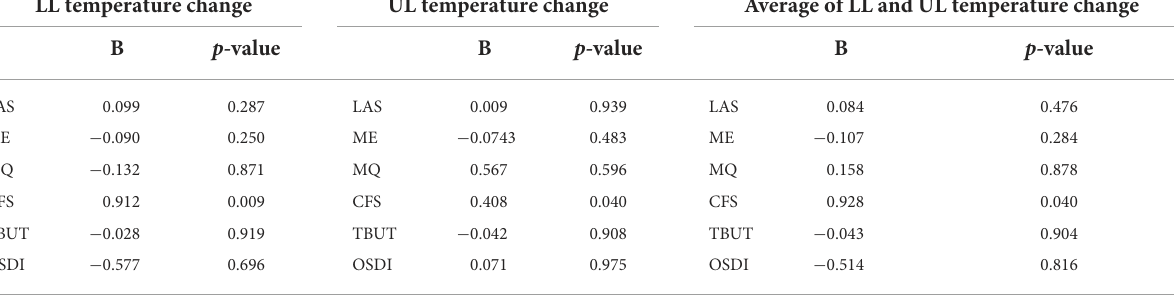
TABLE 3 Multivariate linear regression analysis between skin temperature ( ◦ C) change and DE and MGD parameter